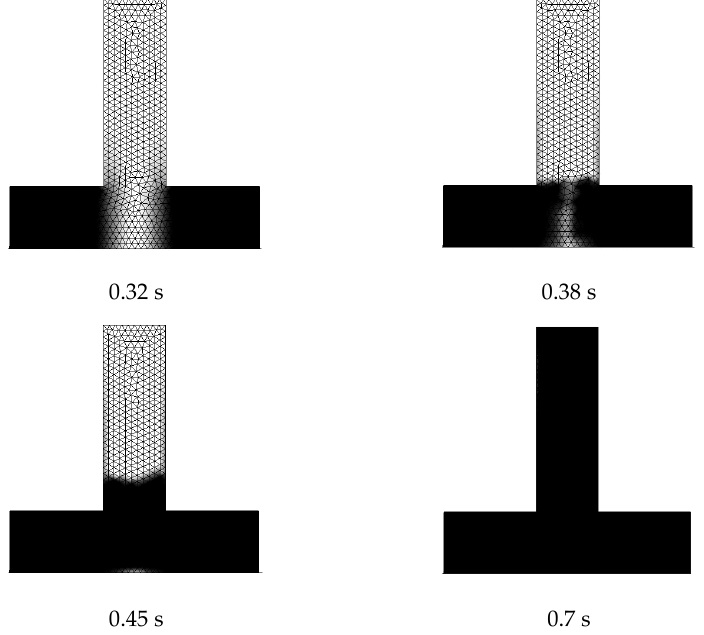
Figure 7. Filling by two opposite inlets in the K shaped cavity.